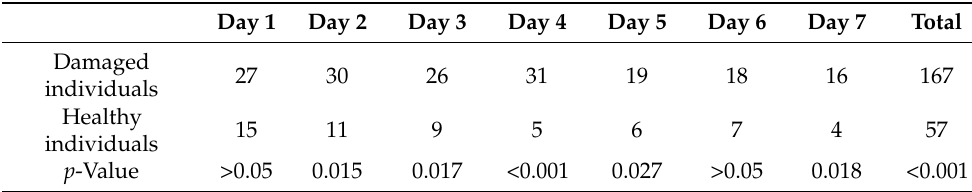
Table 2. The visitation preference difference of Sclomina erinacea individuals between the healthy and the damaged Hypolepis punctata in the field observation for 7 days. Day 1 Day 2 Day 3 Day 4 Day 5 Day 6 Day 7 Total Damaged 27 30 26 31 19 18 individuals Healthy 15 11 individuals p